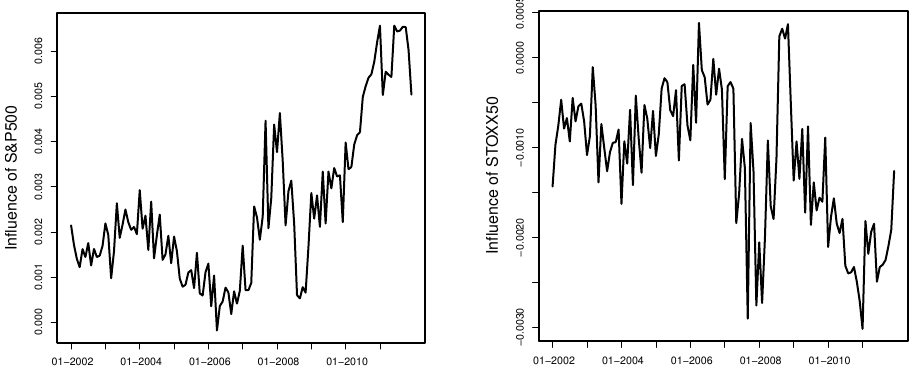
Figure 15. Sensitivity of the logarithmized ARR on S&P500 ( left ) and STOXX50 ( right